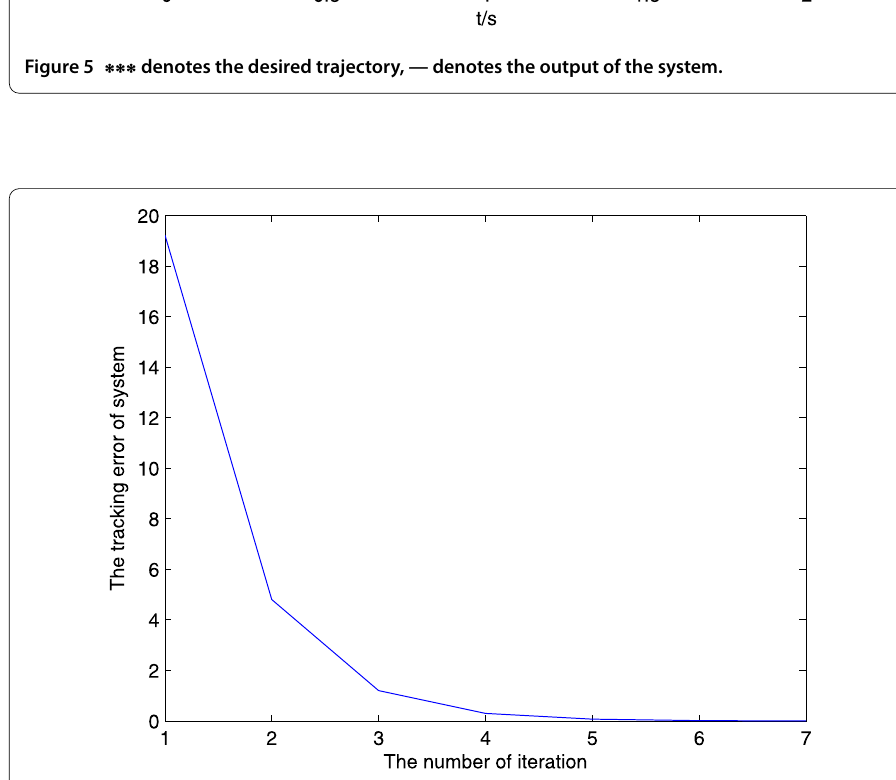
Figure 6 Number of iterations and tracking